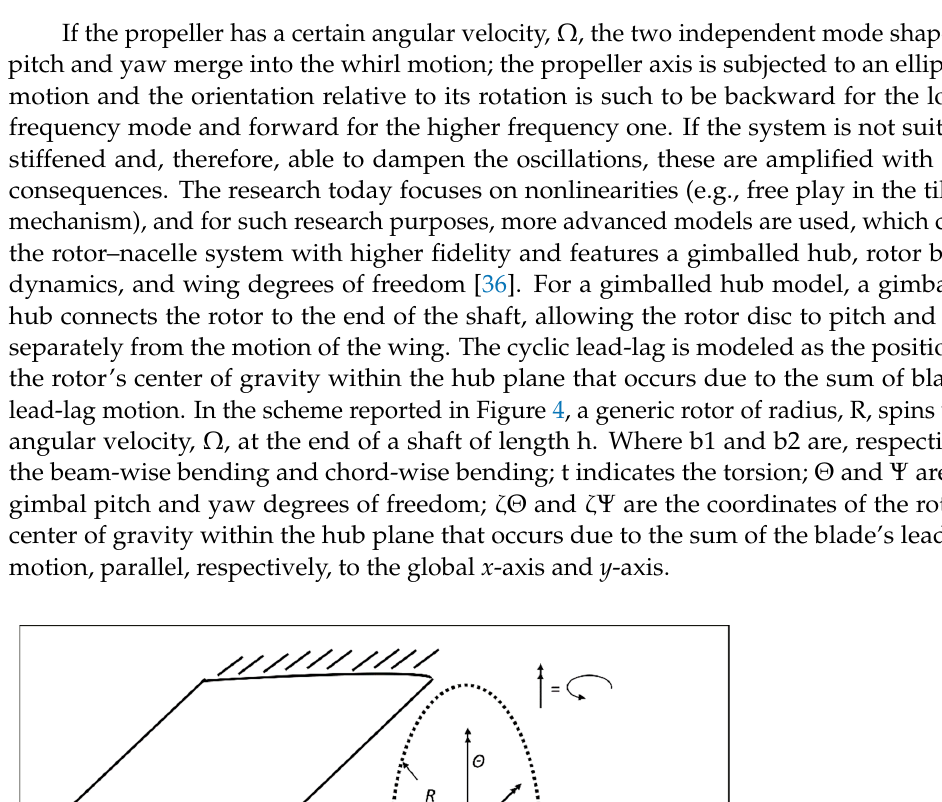
Figure 3. Schematic representation of basic features of the propeller–nacelle dynamic system.